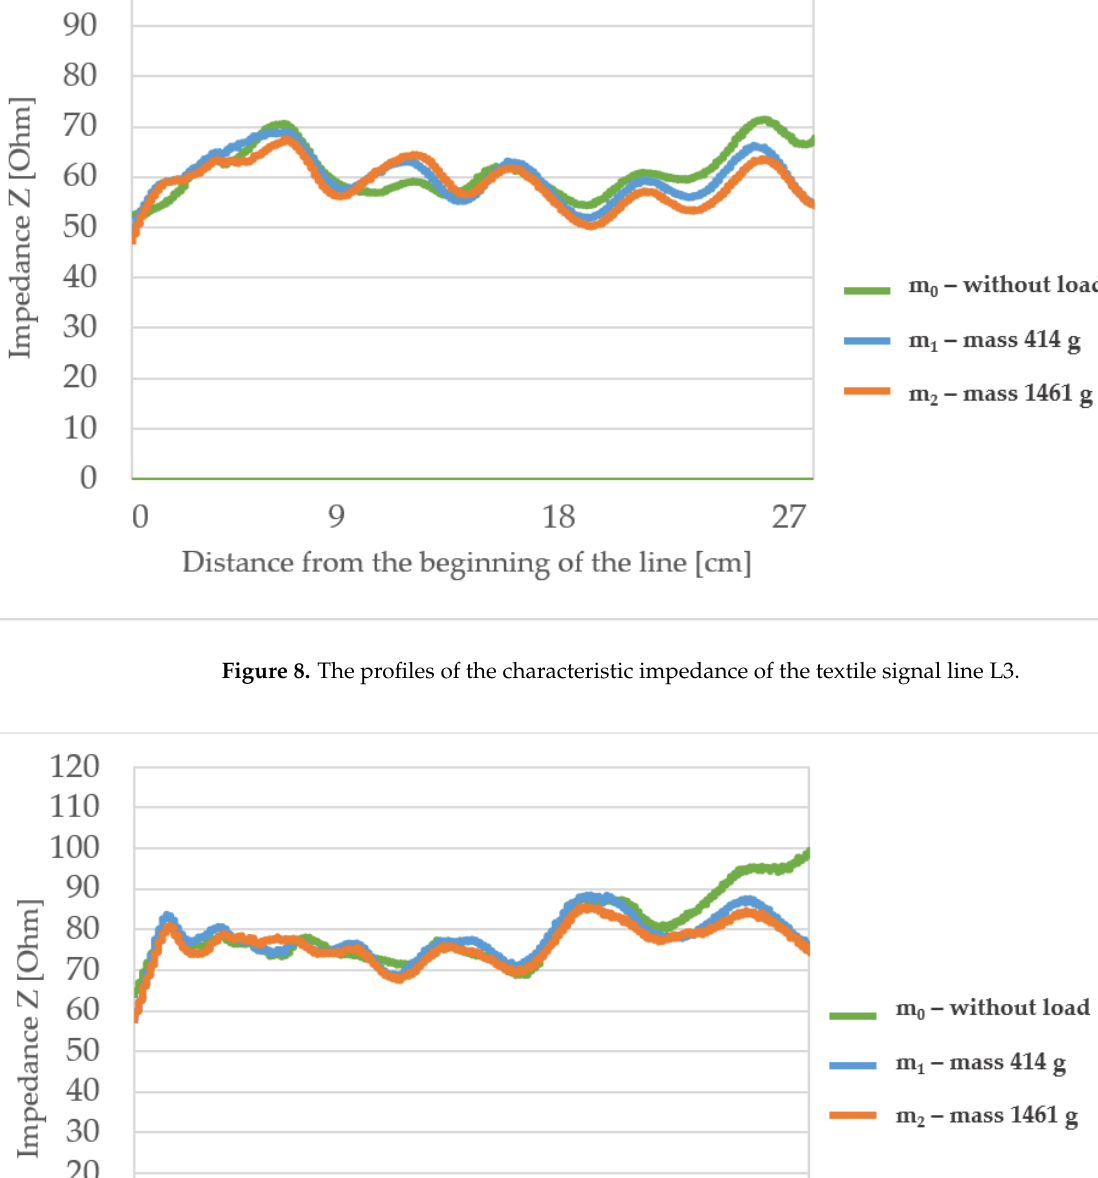
Figure 8. The profiles of the characteristic impedance of the textile signal line L3.